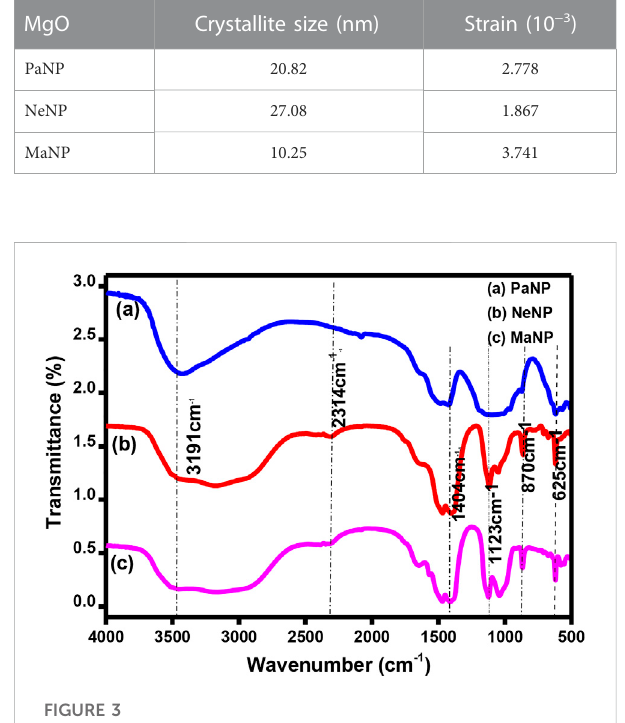
FIGURE 3 FTIR Spectra of Pa, Ne, and Ma nanostructures.